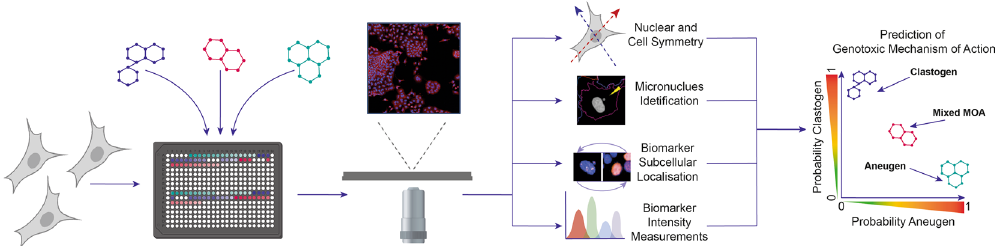
Figure 1. Representation of high throughput screening approach and methodologies to determine small molecule genotoxic potential. Illustrations in figure created with